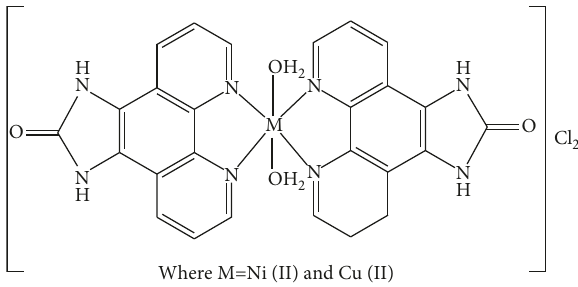
Figure 10: The proposed structure of complexes. Table 5: Inhibition zones of the as-synthesized compounds against four bacterial strains.